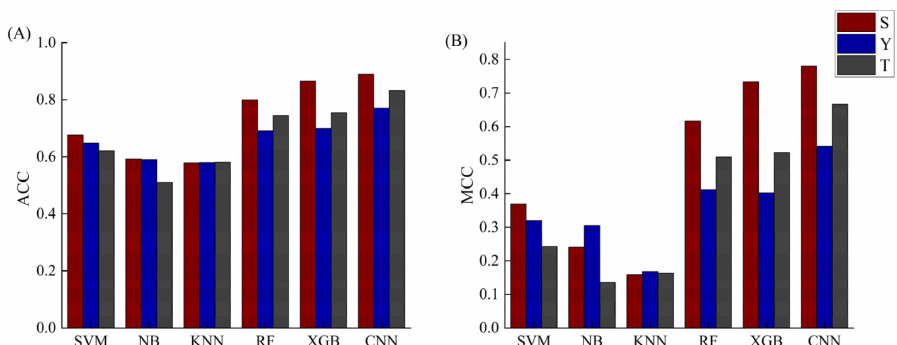
Figure 5. The comparisons between CNN and five machine-learning methods based on protein sequences. ( A ) The ACC values of CNN and five machine-learning methods; ( B ) The MCC values of CNN and five machine-learning methods.